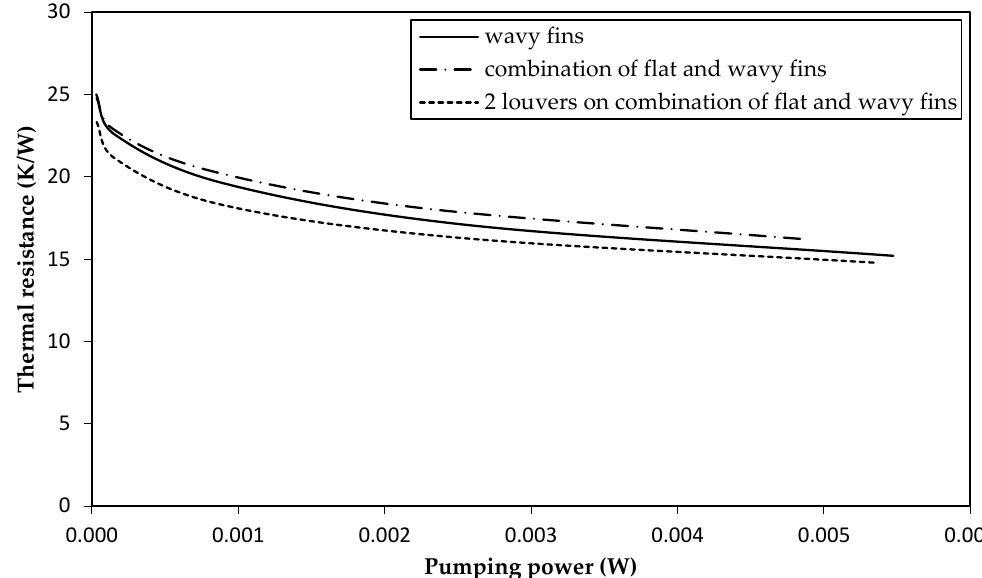
Figure 6. Combination of louver, flat and wavy fins: ( a ) geometry; ( b ) fluid streamlines through louvers.